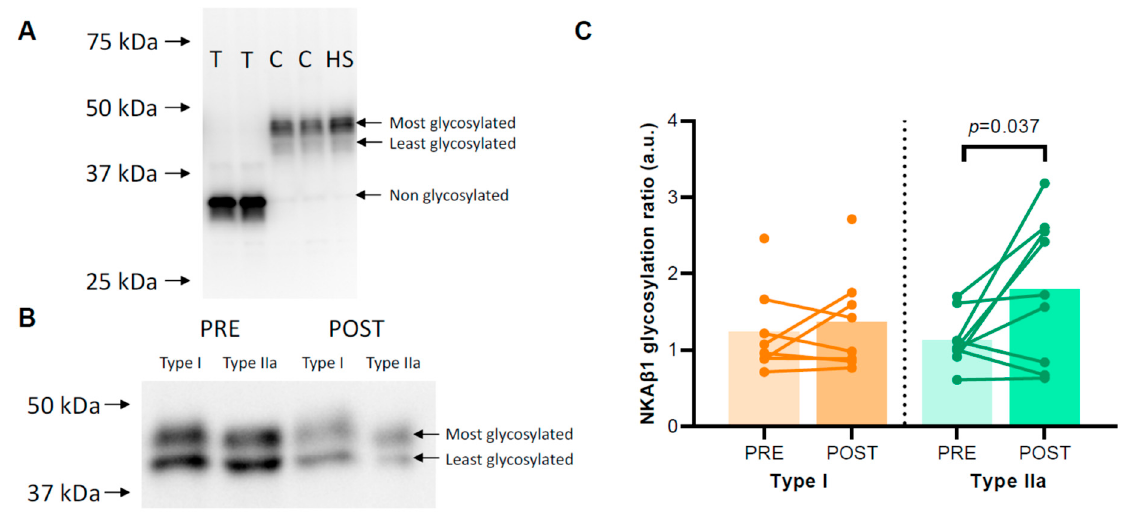
Figure 3. Degree of glycosylation of the Na, K-ATPase (NKA) β 1 subunit. ( A ) A control experiment indicating that the differences between the two upper signals migrating between 40 and 50 kDa are related to the degree of NKA β 1 glycosylation. Human skeletal muscle samples treated with 1 unit N-glycosidase per 40 µg protein (T) or controls without N-glycosidase (C) and a human skeletal muscle lysate (HS) were loaded on a gel, and afterwards, the membrane was incubated with an NKA β 1 antibody. ( B ) Representative Western blots for the pooled single fibres are shown. The NKA β 1 glycosylation ratio was determined as the ratio between the most glycosylated signal and the least glycosylated signal between 40 and 50 kDa. ( C ) NKA β 1 glycosylation ratios in human skeletal muscle type I and IIa fibres of healthy young men ( n = 8–9) before (PRE) and after (POST) 6 weeks of high-intensity interval training (HIIT) 3 times weekly.